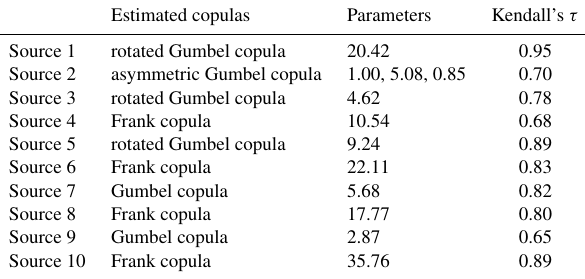
Table 7. Estimated optimal copulas, copula parameters, and Kendall’s τ for each source of the Sagami Trough earthquake.